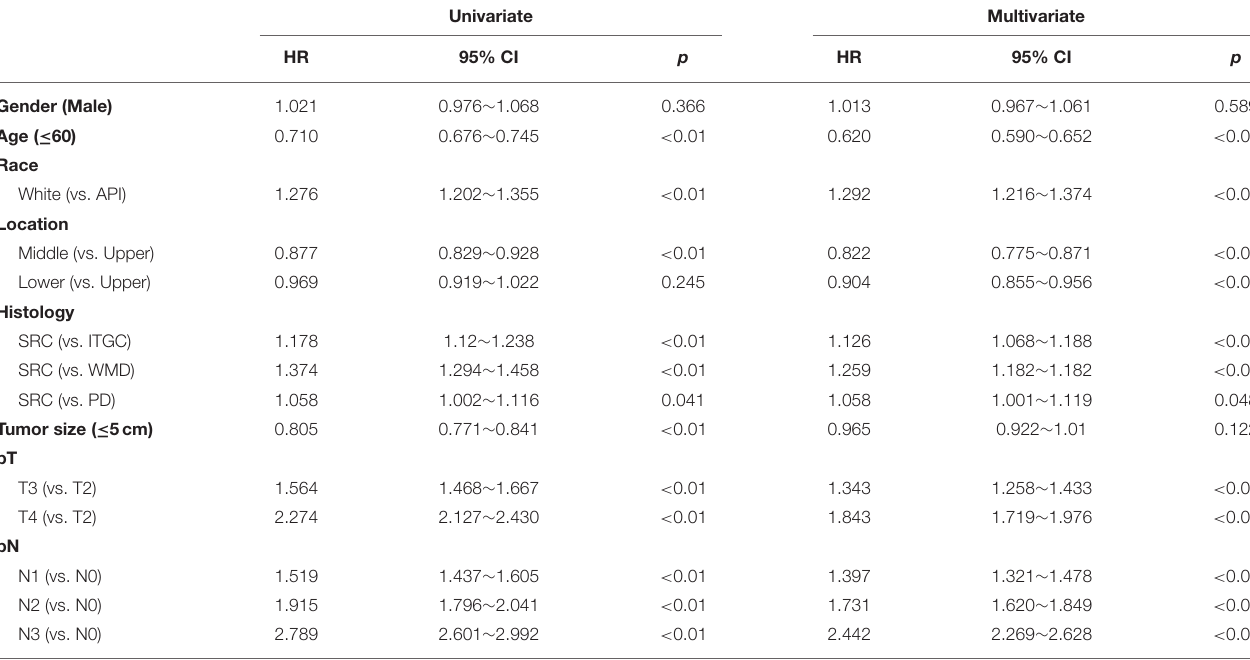
TABLE 4 | Univariate and multivariate analyses of prognostic factors for overall survival in advanced gastric cancer. Univariate